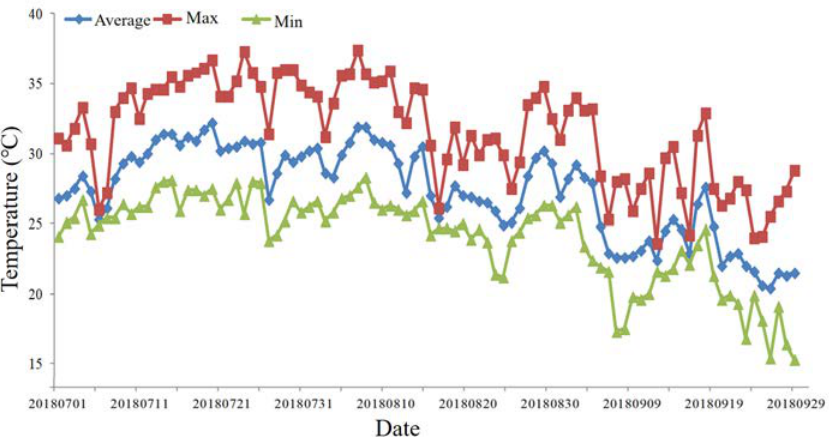
Figure 6. Meteorological data of rice at full heading stage. Average: average temperature. Max: maximum temperature. Min: minimum temperature.